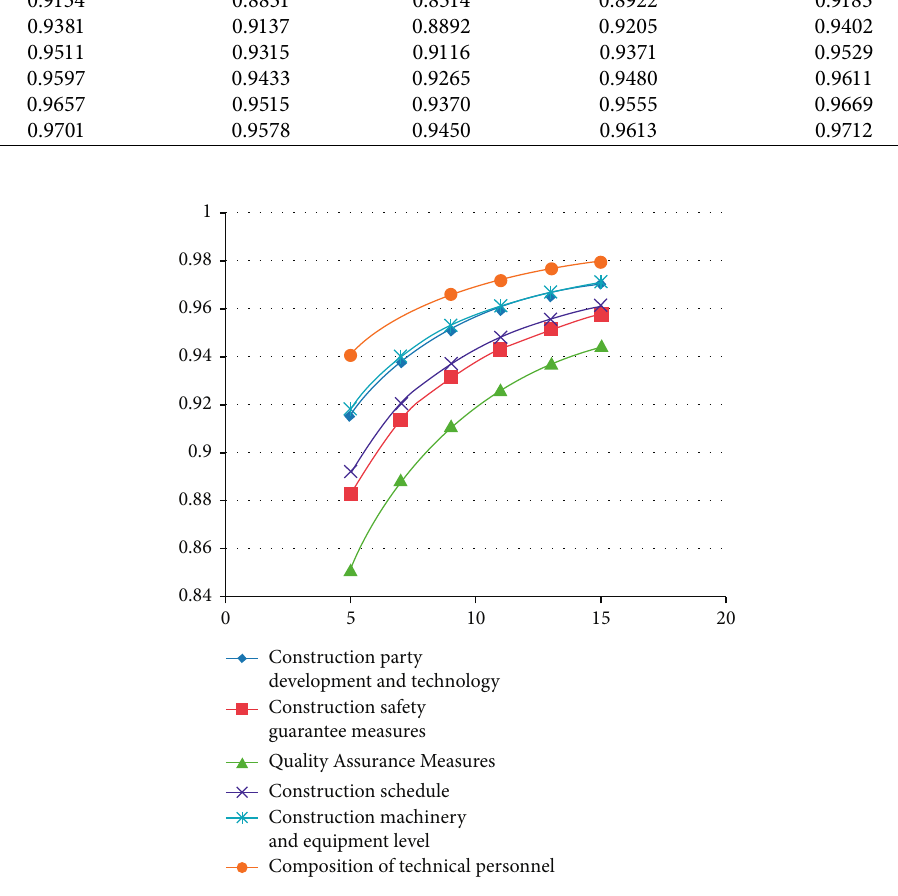
Figure 5: Change trend of generalization coefficient of each indicator